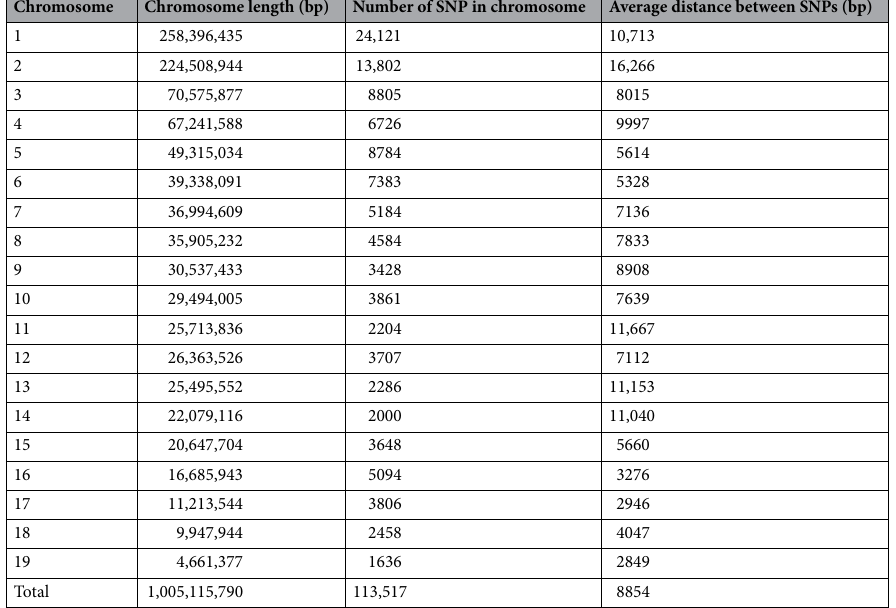
3 different traits: PetalMagArea, PetalMag and LipMag (Table 2). These genes include MYB52 -like gene and the MYB11 promoter region around the significant SNPs S2_195281745 and S5_43813578, respectively, correlated